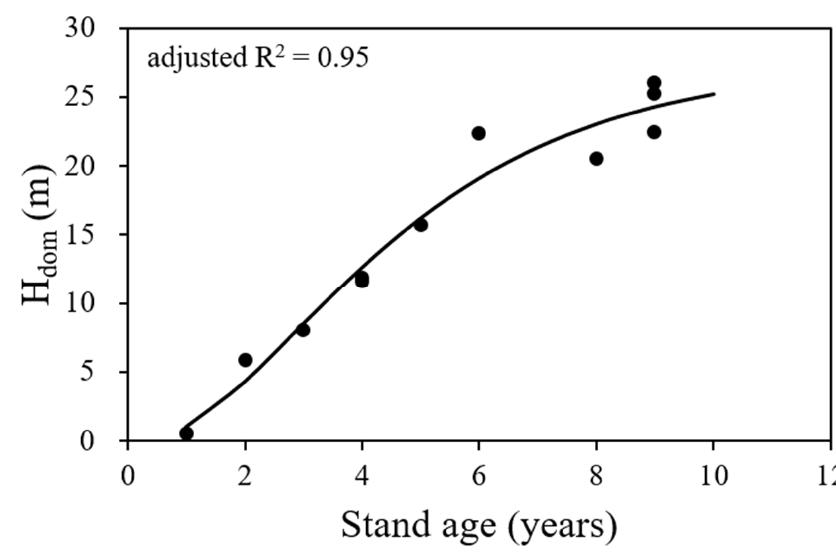
Figure 2. H dom growth model using the Chapman–Richards equation.